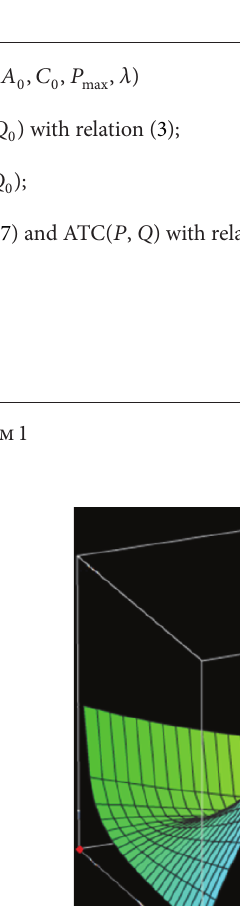
Algorithm 1 starts with an initial solution (production